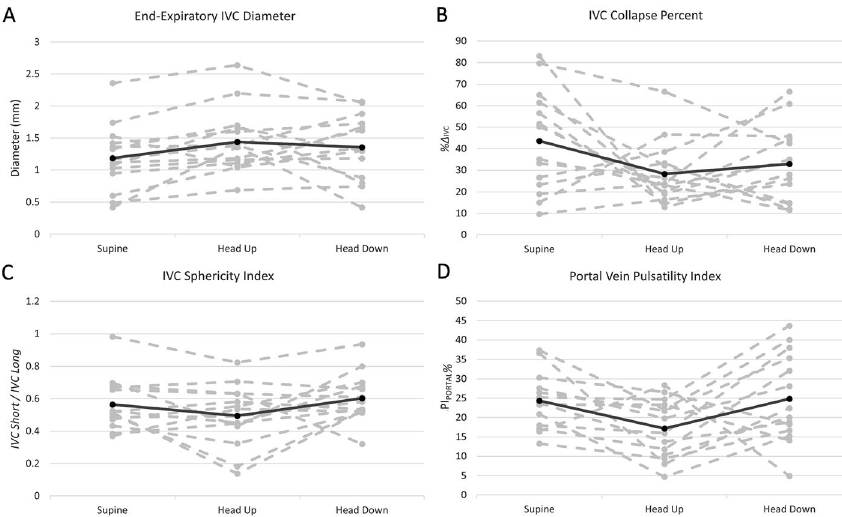
Fig. 5 The effect of preload on the inferior vena cava and portal pulsatility. Each dashed grey line indicates a single subject, the black line is the average of all subjects. A End‑expiratory inferior vena cava (IVC) diameter; B IVC collapse; C IVC sphericity index and D the portal vein pulsatility